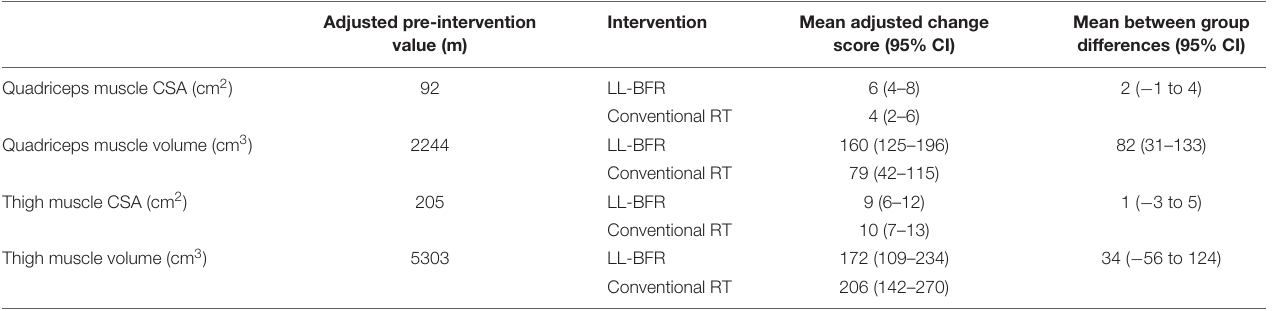
TABLE 3 | Post-intervention values and change score of muscle cross-sectional area (CSA) and muscle volume after adjusted for differences in values scored at baseline (using analysis of covariance—ANCOVA). Adjusted pre-intervention value